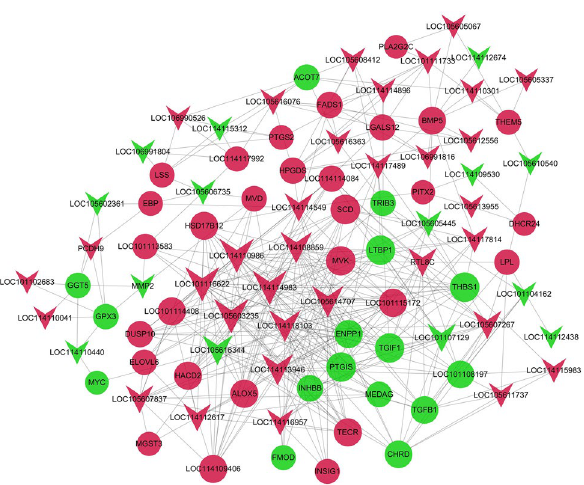
Figure 5. Target relationship between lncRNA and mRNA. The circle in the node represents mRNA, and the triangle represents lncRNA, edge represents interaction between lncRNA and mRNA. In addition, red represents up-regulation of Duolang sheep, green represents